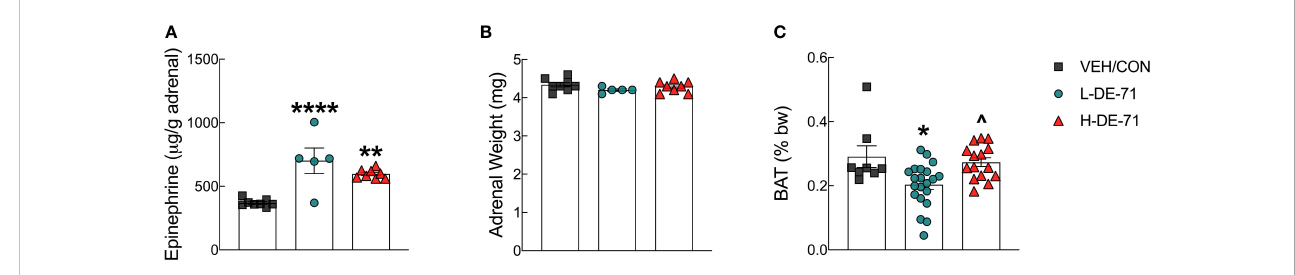
FIGURE 6 Effects of DE-71 on adrenal epinephrine content and thermogenic brown adipose tissue mass. (A) Epinephrine content measured in adrenal glands harvested at necropsy. (B) Corresponding adrenal weights. (C) Interscapular brown adipose tissue (BAT) collected at necropsy was expressed as a percent of body weight. *indicates signi fi cantly different from VEH/CON (* p <0.05, ** p <0.01, **** p <0.001); ^indicates signi fi cantly different from L-DE-71 (^ p < 0.05). Bars and error bars represent values expressed as mean ± s.e.m. n=5-8/group for epinephrine and n =8-21/group for BAT. [ Permission obtained for reuse of panel in Figure 1B , Kozlova et al, 2022, Front. Endocrinol. 13: 997304]